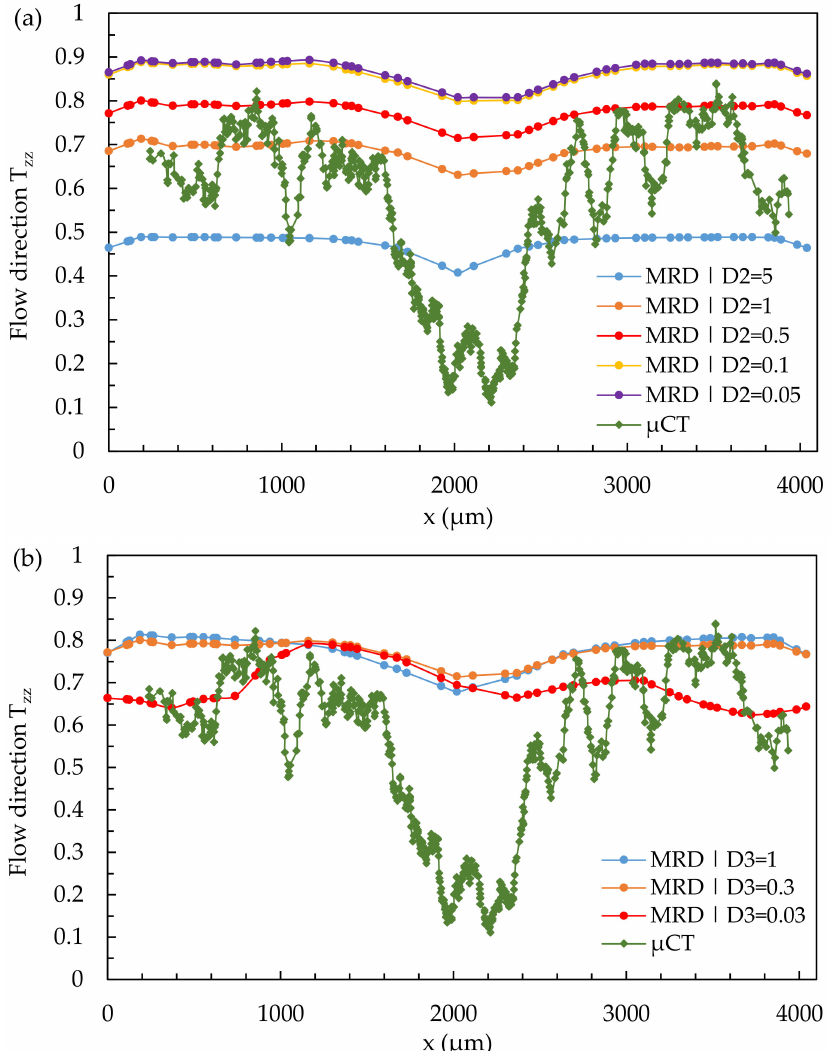
Figure 19. Quantitative results of fiber orientation in T zz -direction over the cross-section characterized by µ CT and predicted by the 3D mesh under variation of the parameters D 2 ( a ) and D 3 ( b ) at location